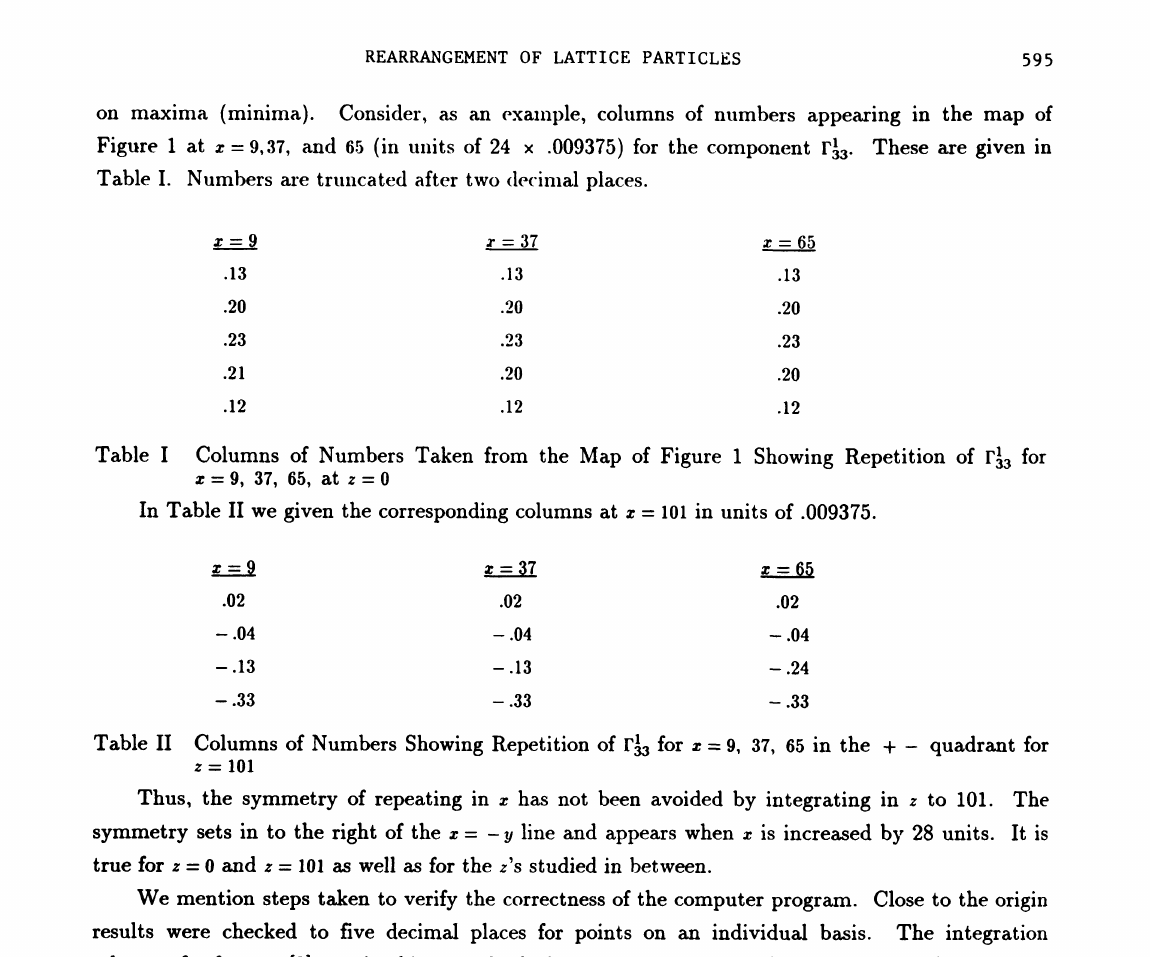
Table II Columns of Numbers Showing Repetition of r3 for 9, 37, 65 in the + quadrant for